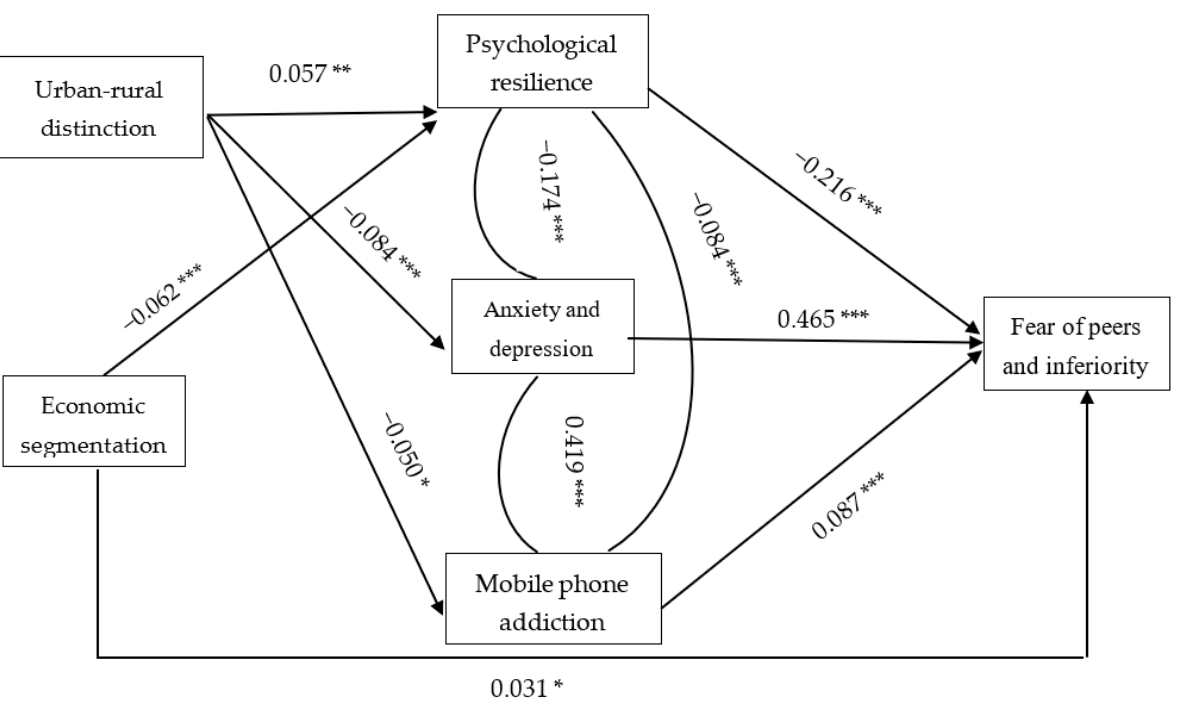
Figure 1. Model path diagram based on the standardized regression coefficients. *** p < 0.01, ** p < 0.05, * p < 0.1.